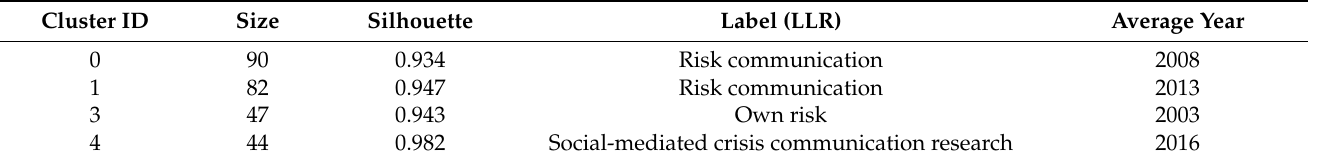
Table 7. Main clusters for crisis and risk communication research.